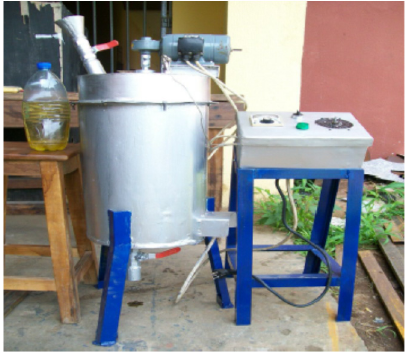
Figure 4. The fabricated 20 L unit for biodiesel production [53].